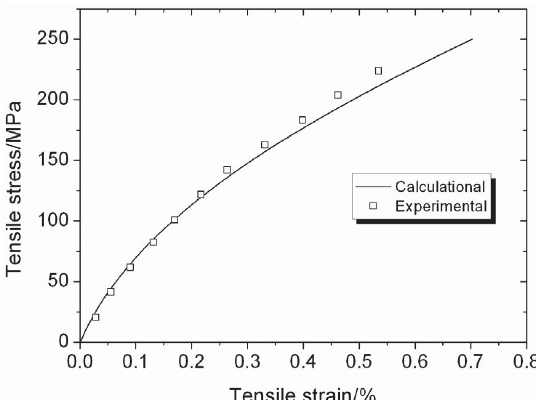
Fig. 4. Comparison of tensile stress-strain curves obtained by calculational and experimental methods.